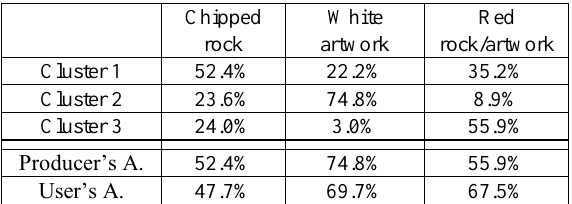
Table 3: Confusion matrix test 2.